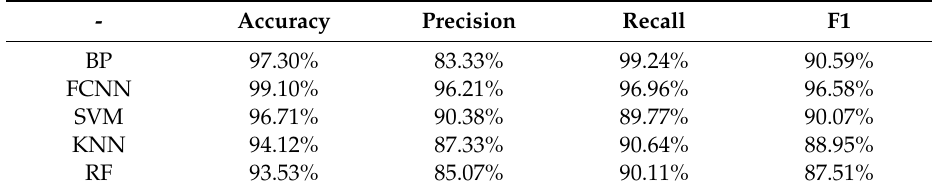
Table 5. Classification results of five algorithms.